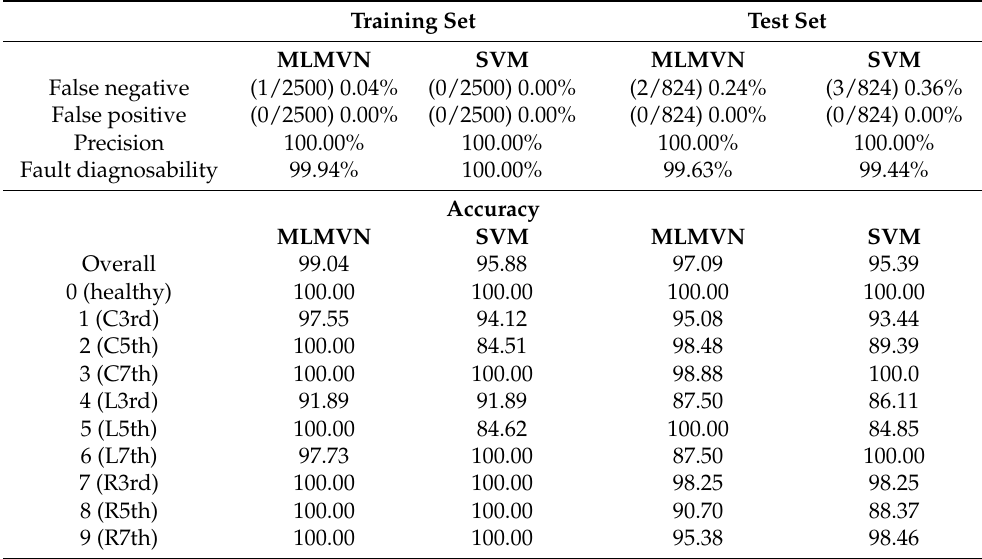
Table 6. Fault classification results in a network filter with evaluation of the response.